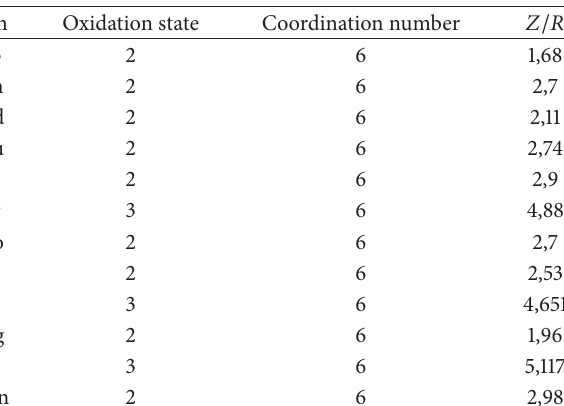
Table 6: Metal ion charge to radius ratio [8].